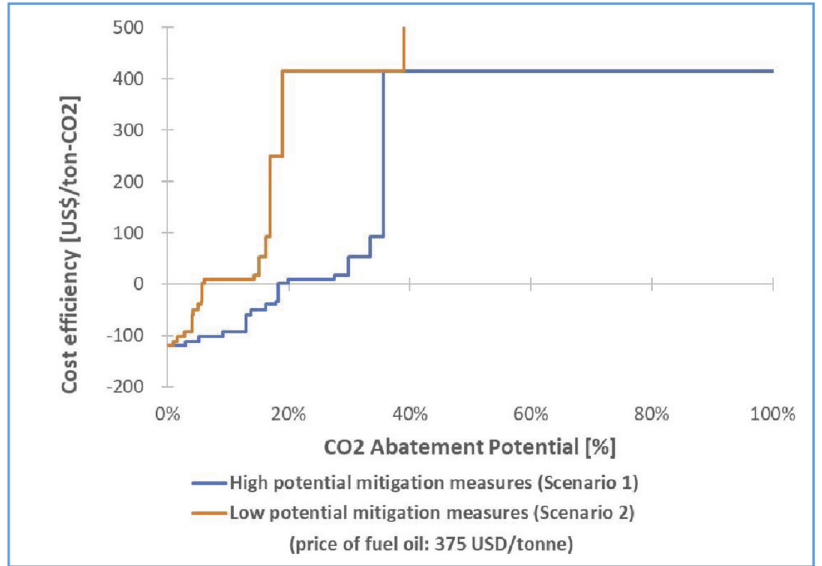
Figure 6. Marginal abatement cost curve for 2050. Source: [3].